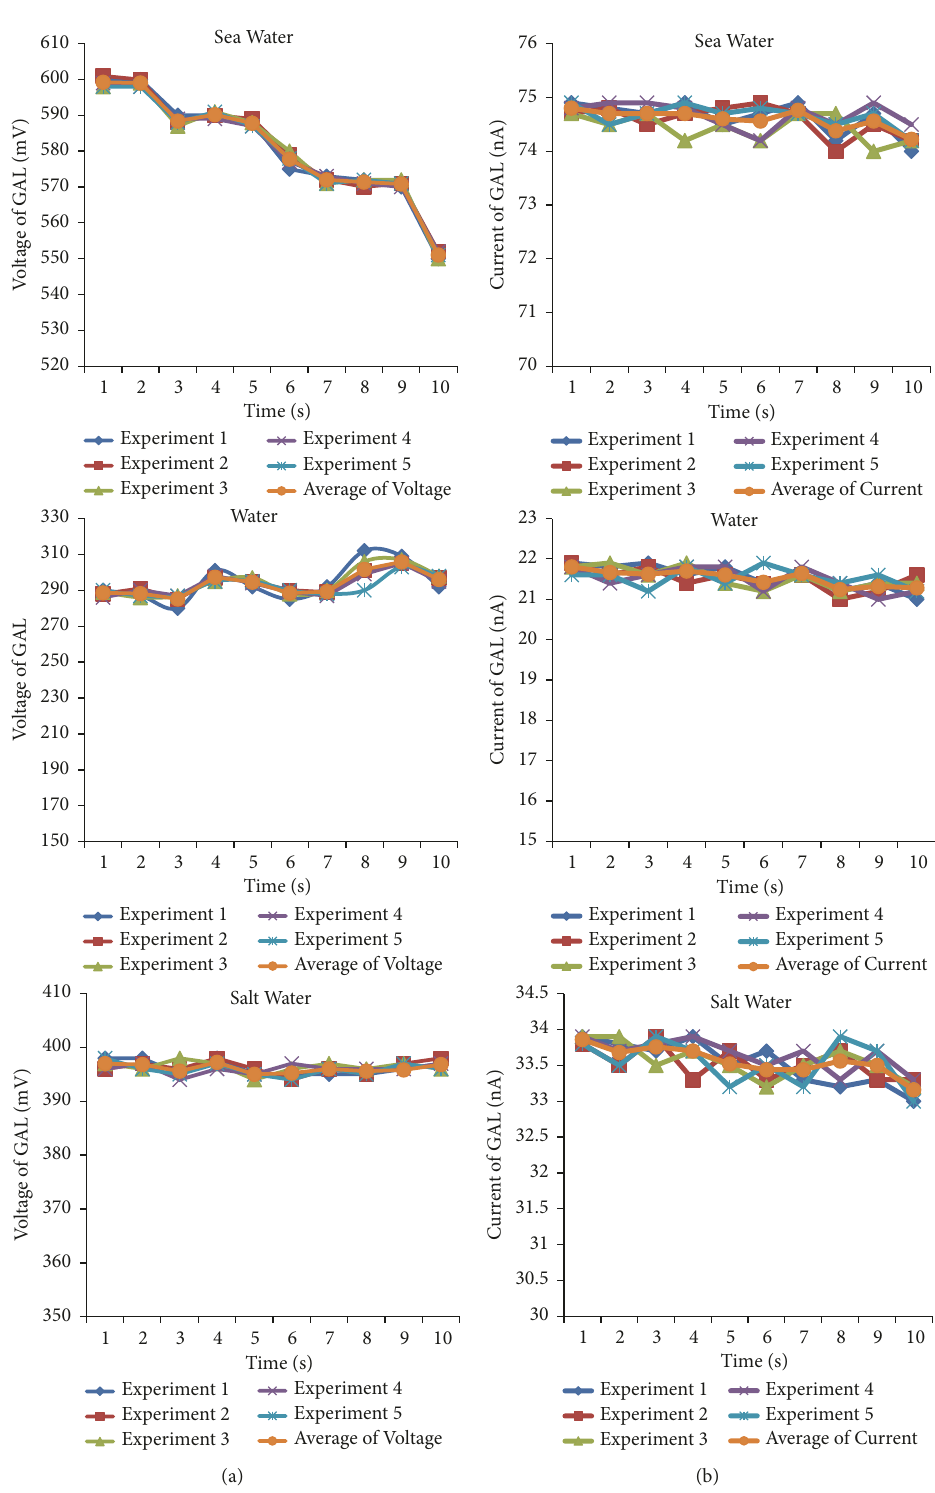
Figure 9: (a) Range of GAL voltage. (b) Range of GAL